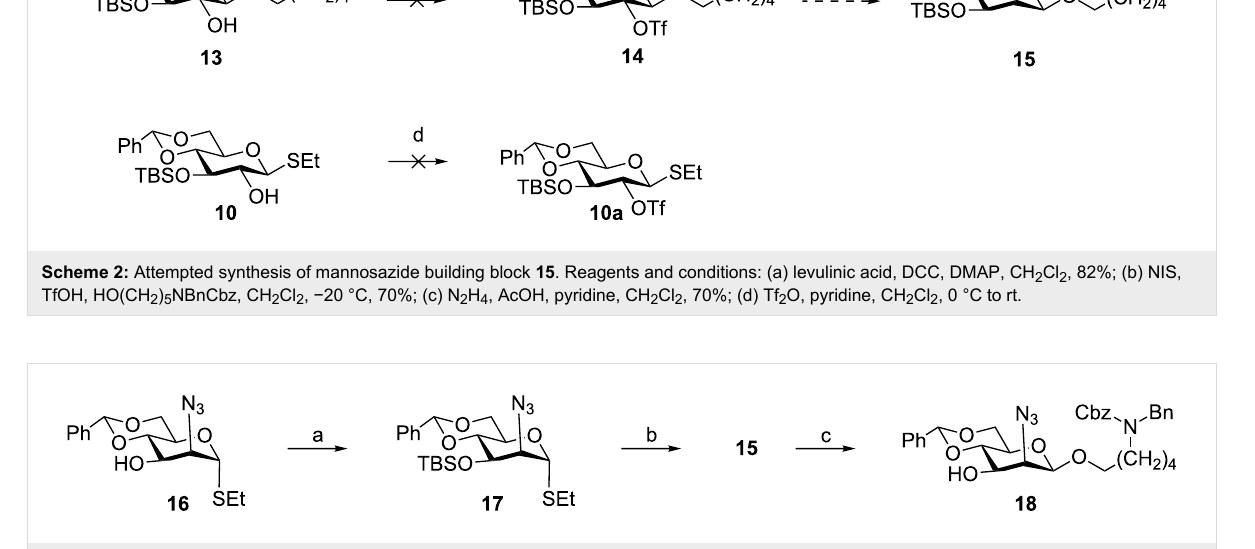
Scheme 3: Synthesis of mannosazide building block 18 . Reagents and conditions: (a) TBSCl, imidazole, DCM, 0 °C to rt, 85%; (b) NIS, TfOH, HO(CH 2 ) 5 NBnCbz, CH 2 Cl 2 , − 20 °C, 61%; (c) TBAF, THF, 0 °C,